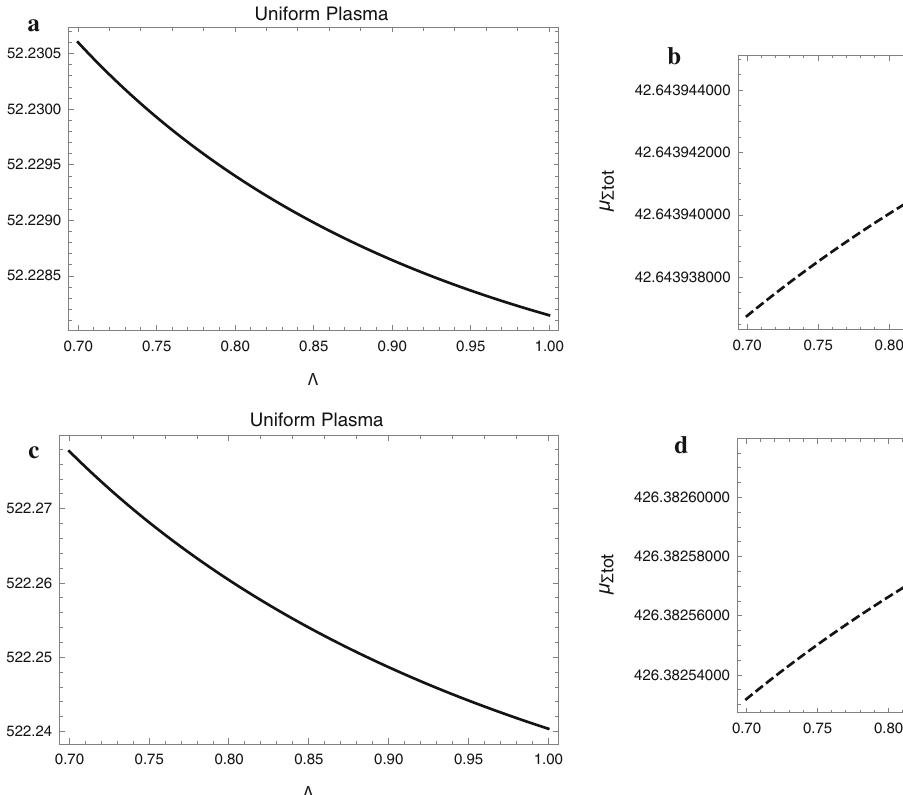
Fig. 16 a Plot of μ Σ tot vs. Λ when β = 0 . 001 for uniform plasma. b Plot of μ Σ tot vs. Λ when β = 0 . 001 for the SIS distribution. c Plot of μ Σ tot vs. Λ when β = 0 . 0001 for unifomr plasma. d Plot of μ Σ tot